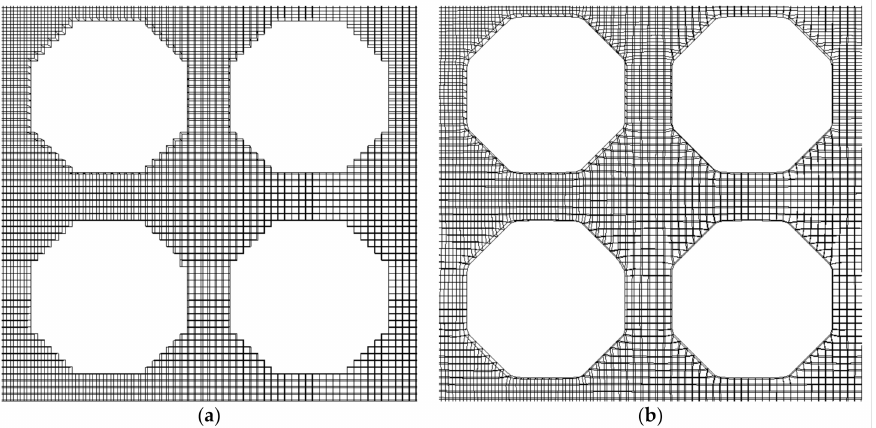
Figure 3. Gridding for vapor extraction (VAPEX) test. ( a , b ) are castellated mesh and snapped, layered mesh respectively.